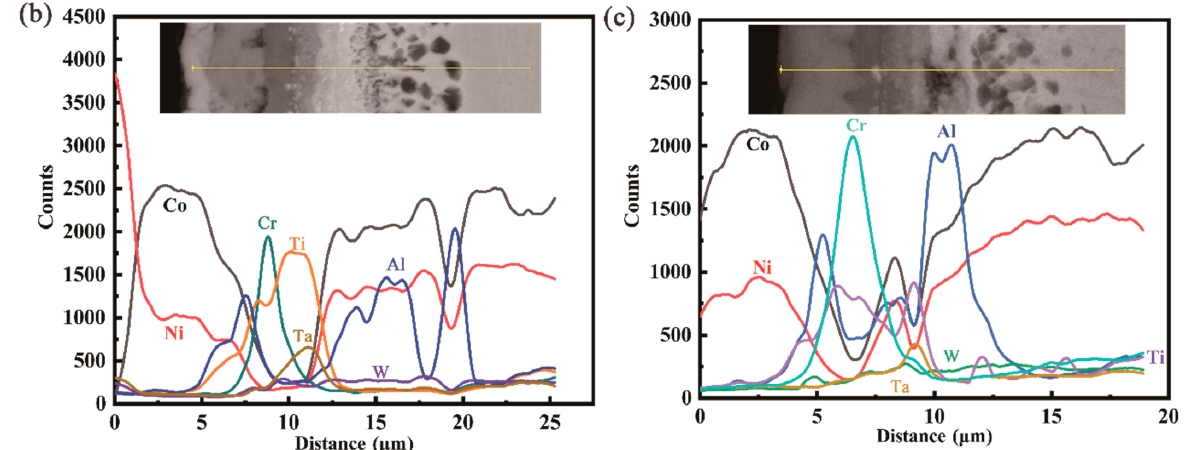
Figure 10. Linear analysis of chemical composition in cross-section after isothermal oxidation at 900 °C for 100h: ( a ) Co-30Ni-10Al-4W-4Ti-2Ta-1Cr; ( b ) Co-30Ni-10Al-4W-4Ti-2Ta-3Cr; ( c ) Co-30Ni-10Al-4W-4Ti-2Ta-5Cr.